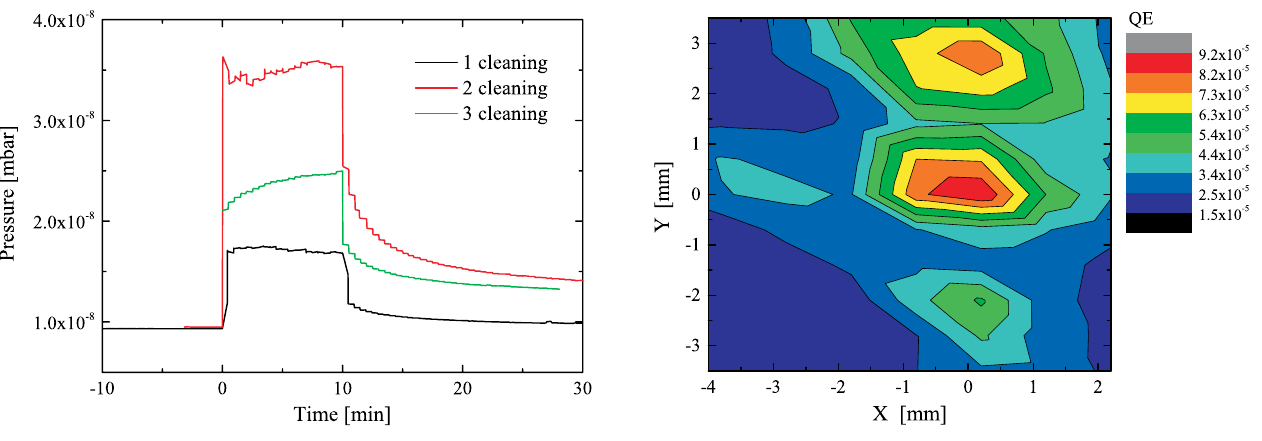
FIG. 5. Gas desorption during the laser cleaning process dur- ing the first cleaning with 0 : 045 mJ = mm 2 , second cleaning with 0 : 087 mJ = mm 2 , and third cleaning with 0 : 09 mJ = mm 2 . Time ‘‘0’’ corresponds to the beginning of the cleaning.